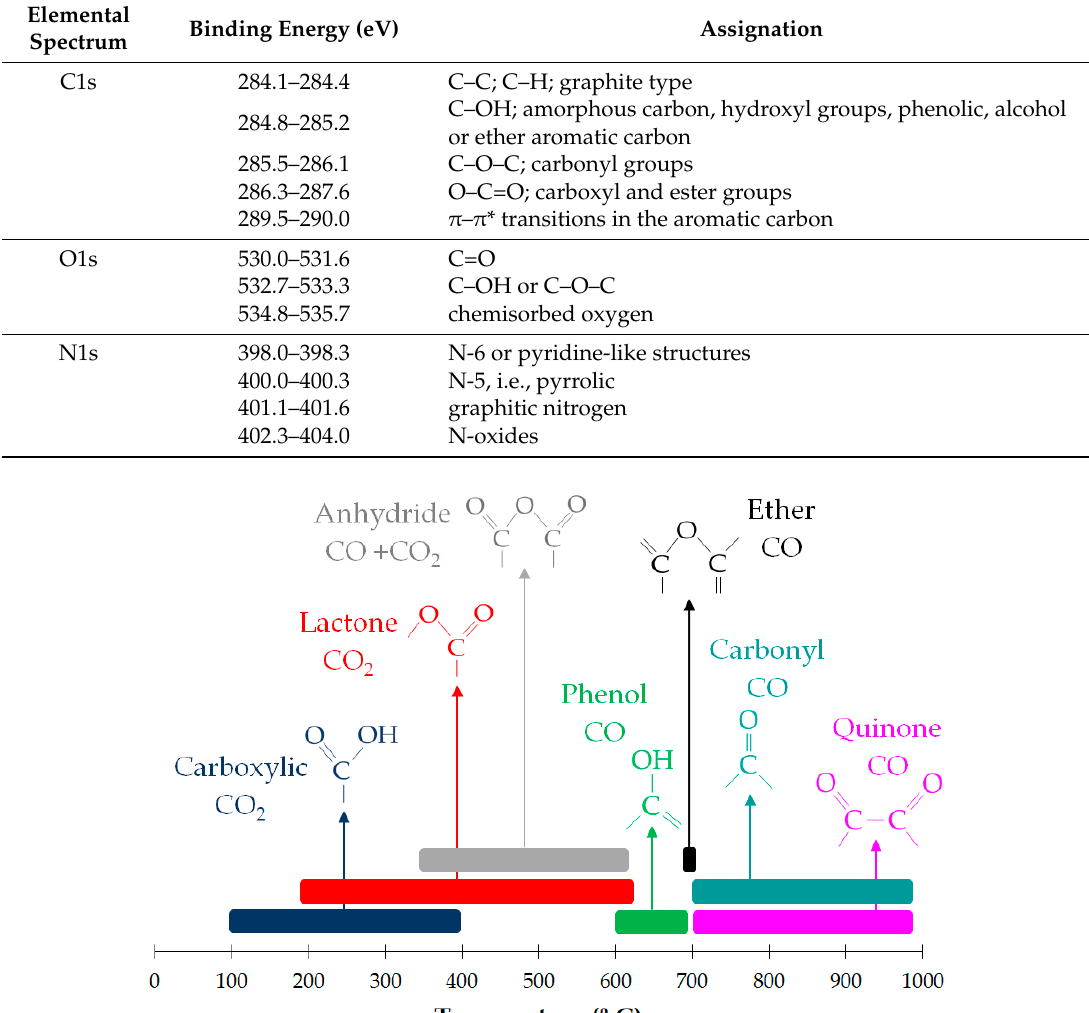
Table 3. Assignment of C1s, O1s and N1s XPS peaks of biomass-derived carbons [126–129].